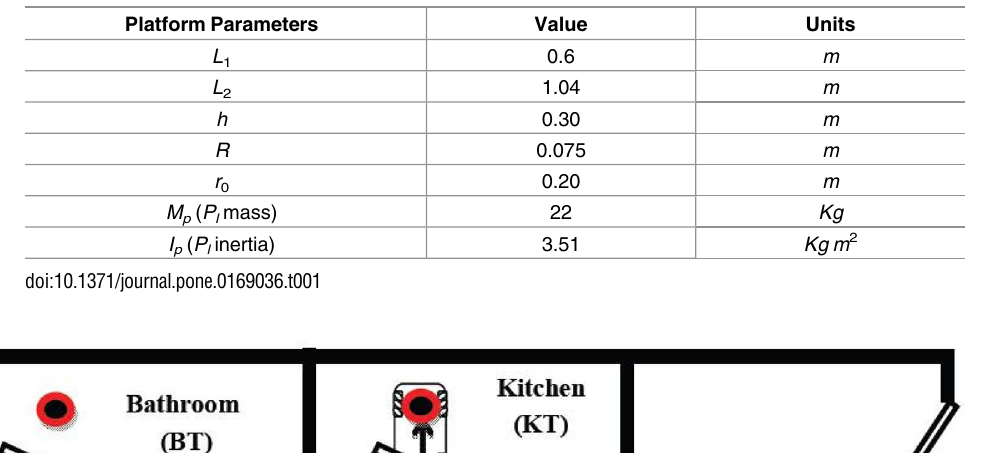
Table 1. The platform parameters.